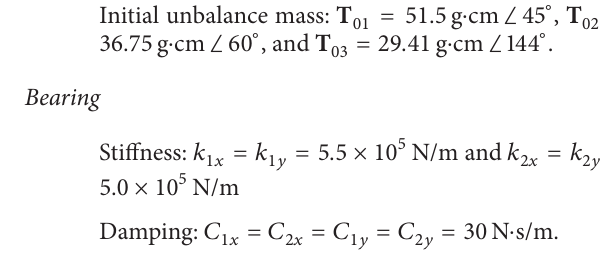
𝑖 th balancing plane